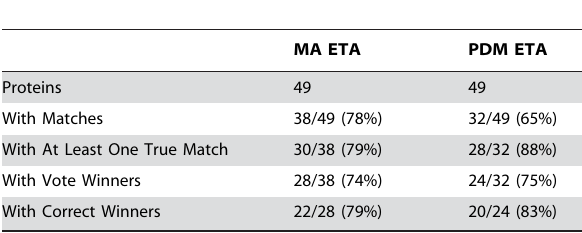
Table 1. ETA Annotation of PSI Test Set Using MA or PDM.